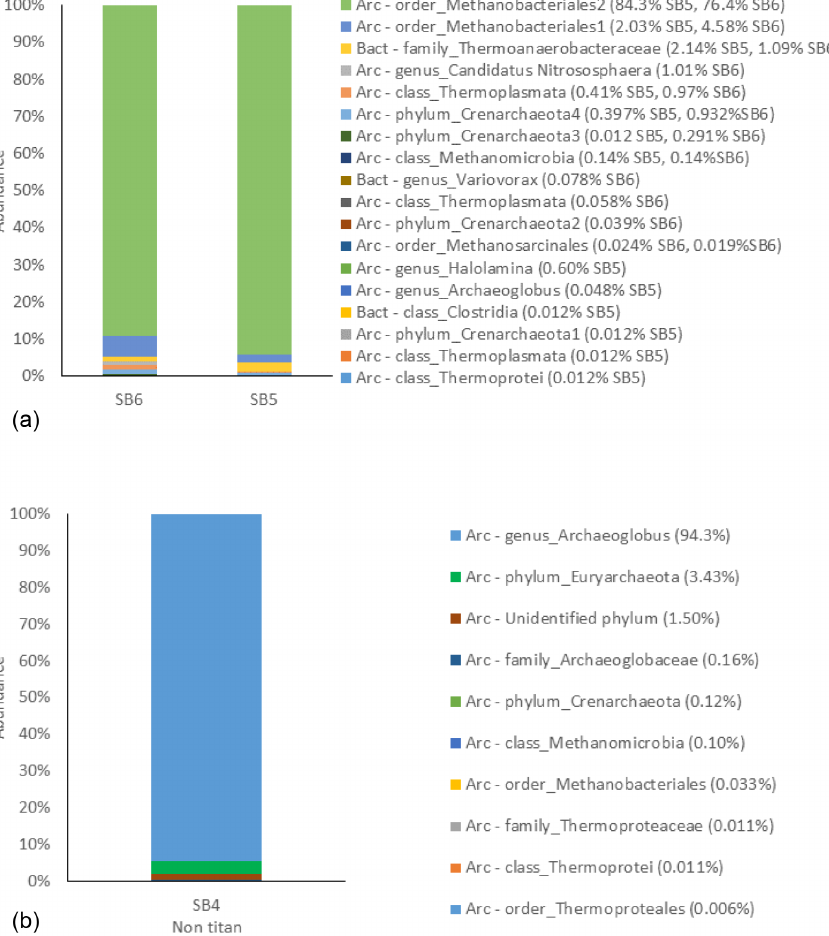
Figure 7. Sequencing results of the 16S rRNA gene with a next-generation sequencing method. (a) The longer reads of the v4–v6 regions with Titanium pyrosequencing on samples SB5 and SB6 (from the borehole). (b) Pyrosequencing of short fragment of the v6 region of the SB4 (from the borehole) v6 library. The columns and the colours show the percentage of each major taxon (see text and percentage of each major and minor taxon on the